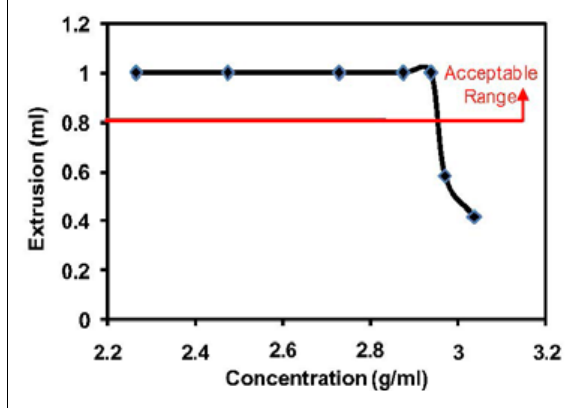
Figure 4. Paste extrusion in different concentrations, using 20-gauge needle and 1 ml